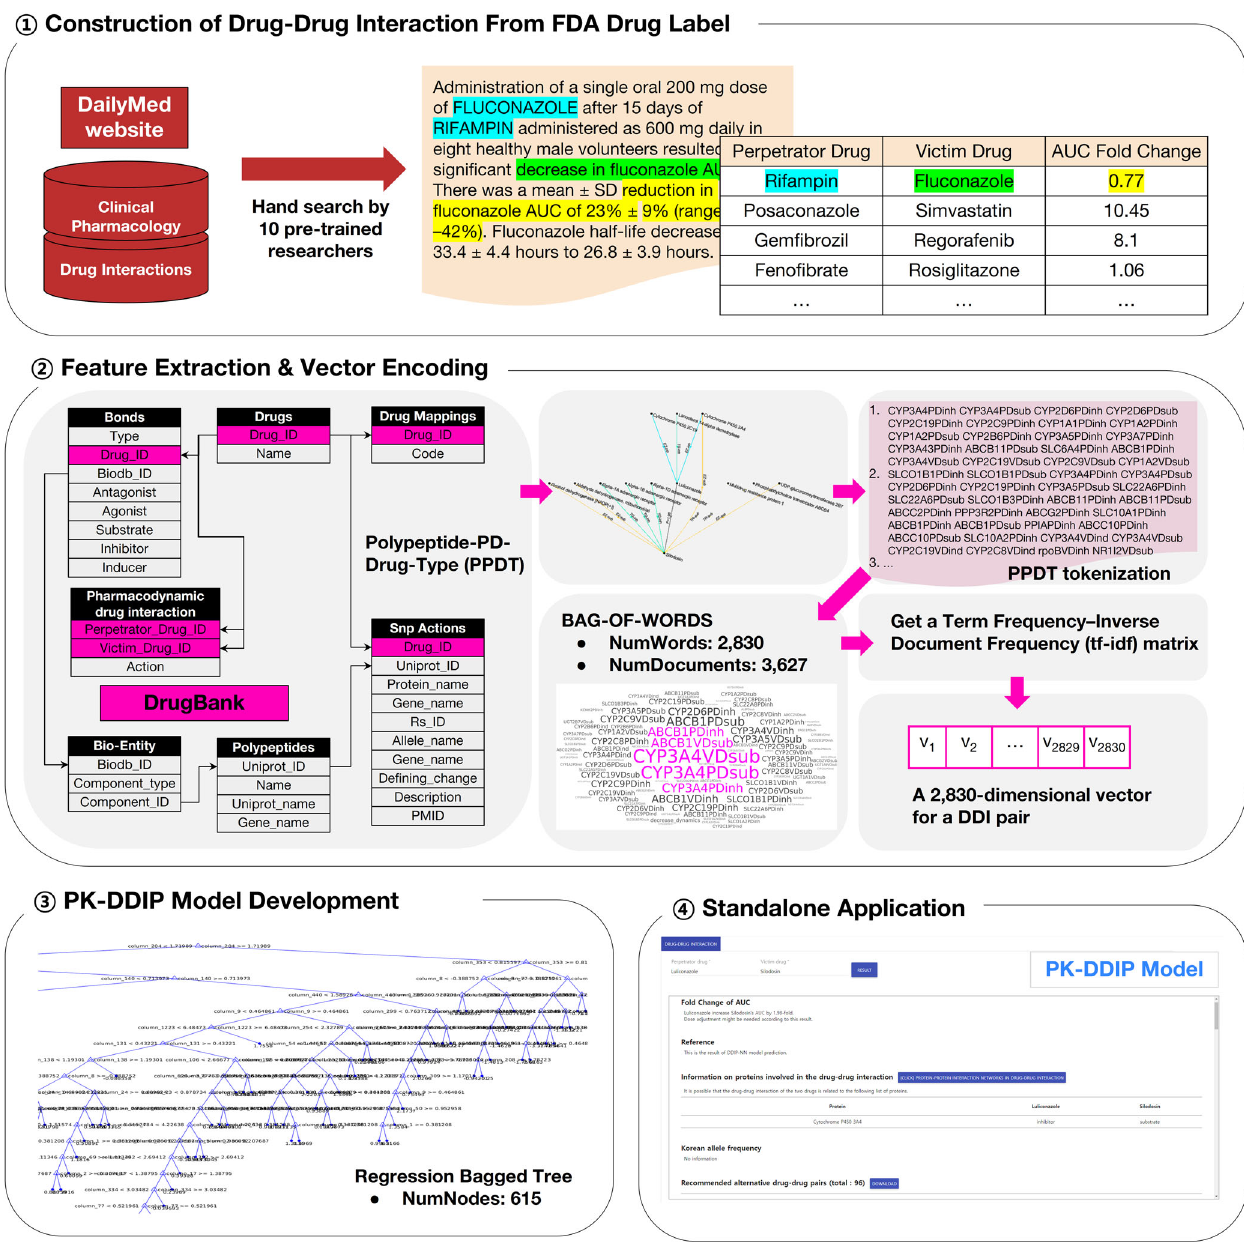
Fig. 1 Drug-drug interaction (DDI) Prediction Pipeline Overview. (Step 1) Reliable Food and Drug Administration (FDA) drug labels were used through the DailyMed website to build the pharmacokinetic (PK)-DDI dataset. A total of 38,711 FDA drug labels were obtained (Evaluation date: May 2020) from sentences/pictures/tables in the clinical pharmacology and drug interaction sections. (Step 2) Information on various drug properties from DrugBank (Evaluation date: March 2021) was obtained. Drug properties data may be arranged around the perpetrator and the victim drugs, and various polypeptides are radially linked. Polypeptide-PD (pharmacodynamics)-Drug-Type (PPDT) tokenization was proposed to represent drug pairs. A bag-of-words containing 2830 unique tokens was obtained. Each drug-drug pair was encoded as a 2830-dimensional vector through normalization with a Term Frequency-Inverse Document Frequency (tf-idf) matrix of bag-of- words. (Step 3) The Bagged (Bootstrap Aggregation) Tree method was used as an application model. The tree consisted of 615 branches